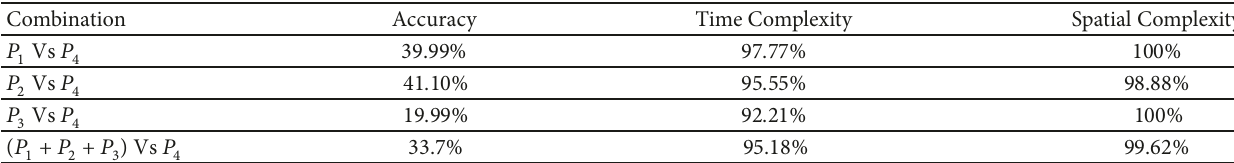
Table 9: Average rate of statistically significant differences in each dimension for all HPO across all 𝐷 𝑖 for all ML algorithms and for each comparison between 𝑃 𝑗 (𝐷 𝑖 ) and 𝑃 4 (𝐷 𝑖 )